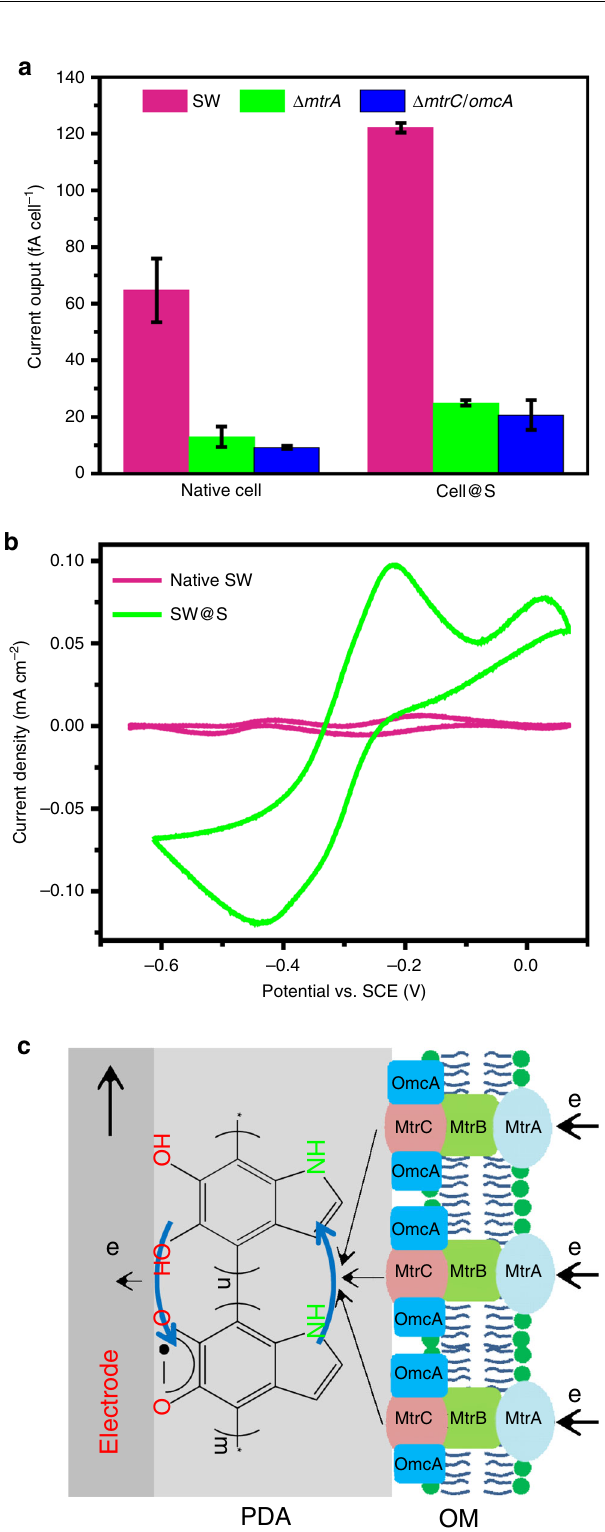
Fig. 4 Wiring up of cellular conduits with a solid electrode by the S collector. a Current output of native or S collector encapsulated cells ( n = 3). Error bars represent standard error (s.e.) determined by three independent experiments. b Background-subtracted CV curves of native (magenta) and SW@S (green) cells, the original CV curves are shown in Supplementary Information (Supplementary Fig. 5). d Proposed electron transfer pathway for the SW@S cell with an